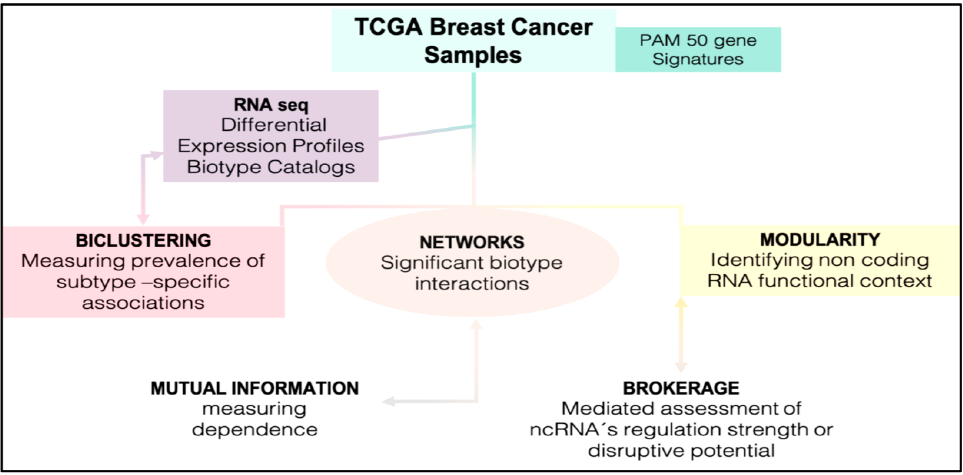
Figure 1. Workflow. Figure 1.